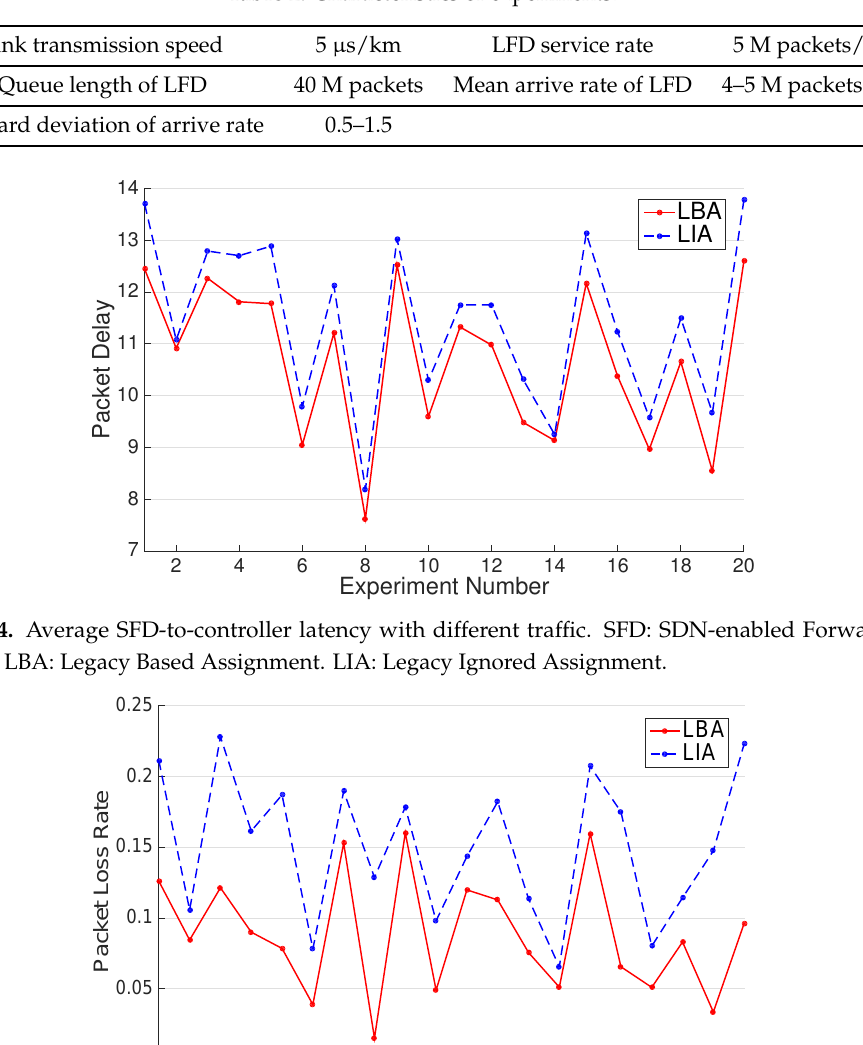
Table 2. Characteristics of experiments.